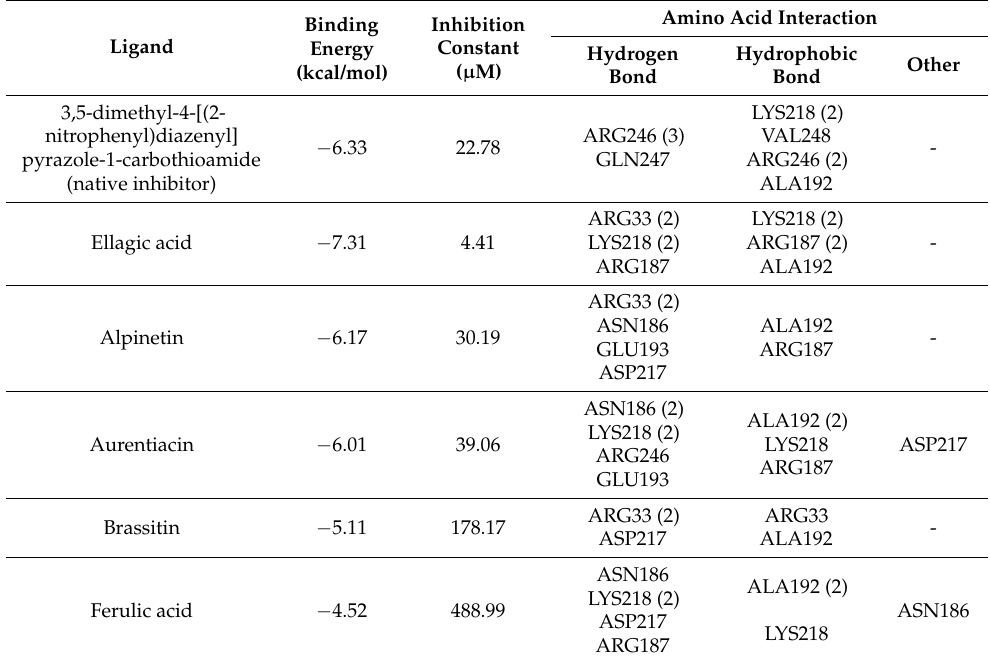
Table 1. Molecular docking results of top 5 identified compounds to NF- κ B binding site .